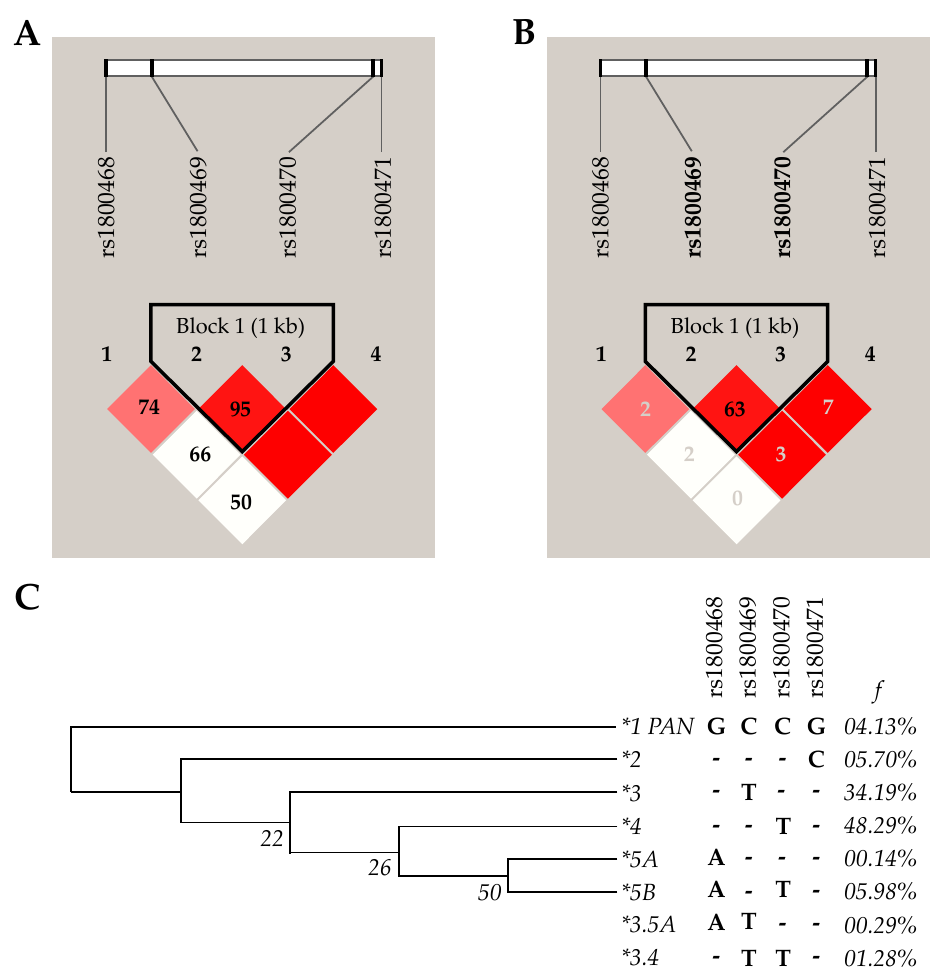
Figure 2. Heatmap linkage disequilibrium and the maximum parsimony analysis of taxa—Values for D’ ( A ) and r 2 ( B ). The evolutionary history was inferred using the maximum parsimony method ( C ). TGFB1 SNVs: rs1800468 (c.–1638 G>A), rs1800469 (c.–1347 C>T), rs1800470 (c.29 T>C) and rs1800471 (c.74 G>C).